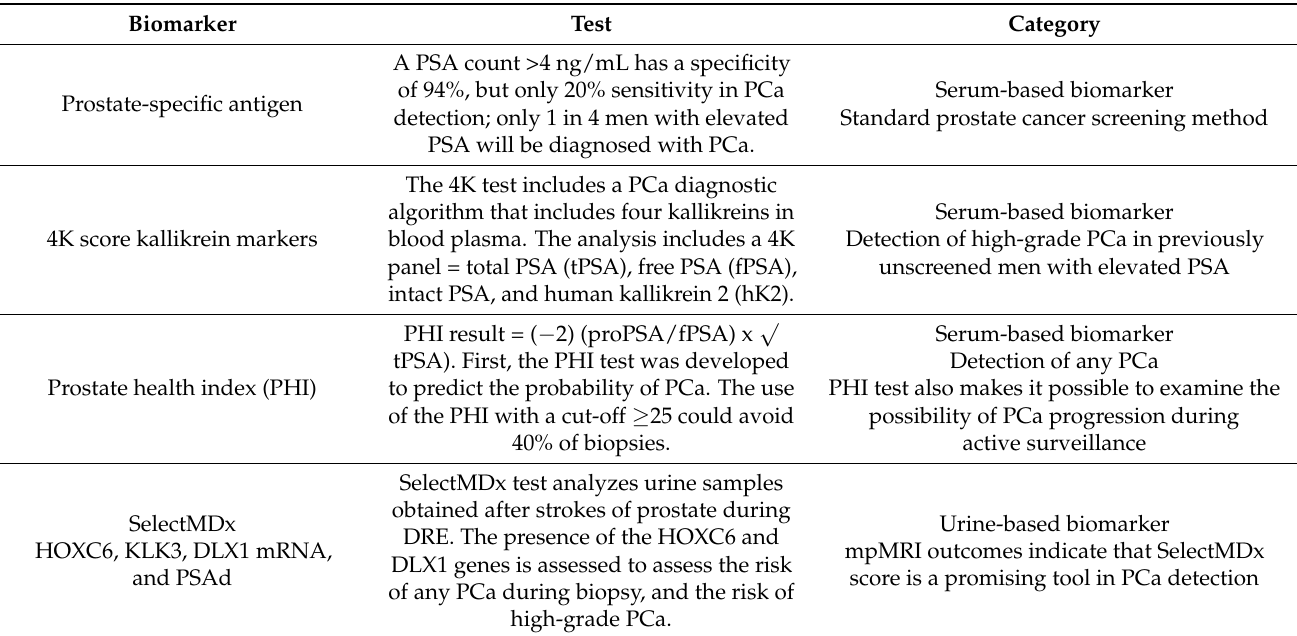
Table 3. Examples of other diagnostic biomarkers classified as serum-based, urine-based, and tissue- based biomarkers used for prostate cancer